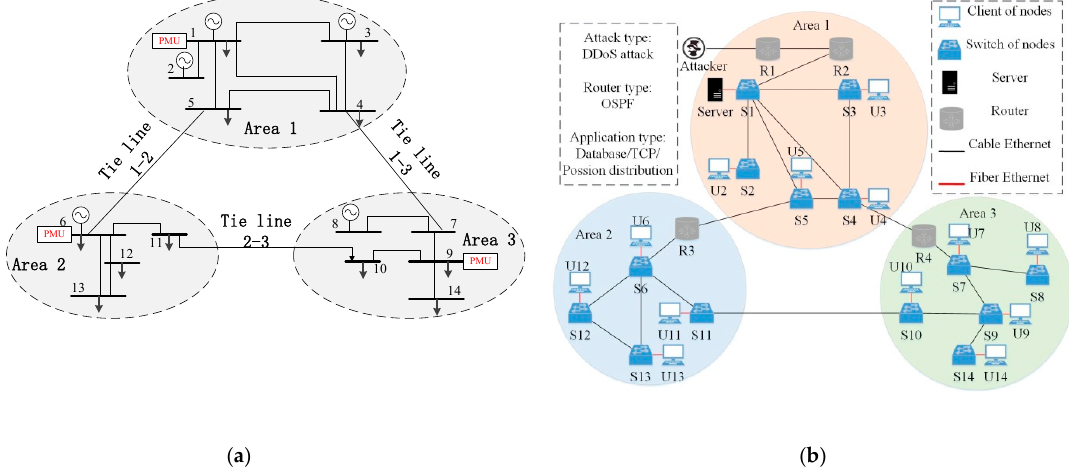
Figure 11. Topology of the IEEE 14-bus system. ( a ) Topology of the power system; ( b ) topology of the communication system.